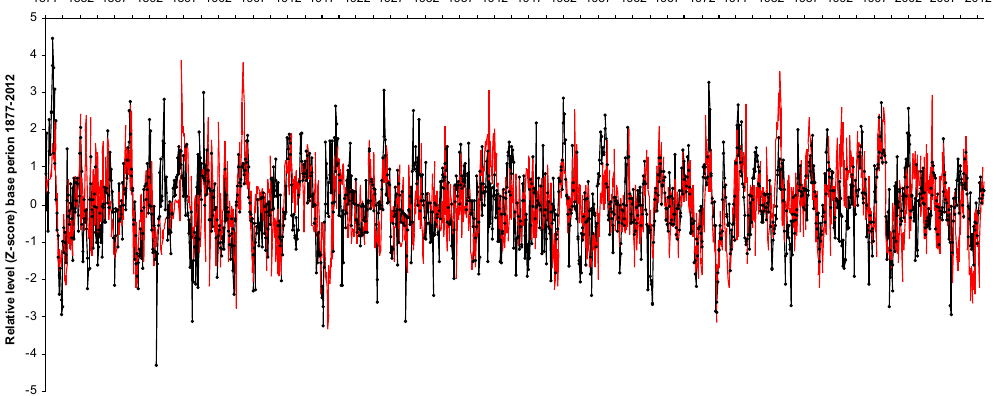
Figure 8. Z -scored monthly data from 1877–2012: sign-reversed SOI (unsmoothed and neither led nor lagged) (red curve); and first- difference global surface temperature smoothed by a 13-month moving average and led relative to SOI by 3 months (black dotted curve). Table 8. OLS dynamic regression between first-difference global surface temperature and reversed Southern Oscillation Index for monthly data for the period 1877–2012, with autocorrelation taken into account. Independent Whole model Whole model LM test for